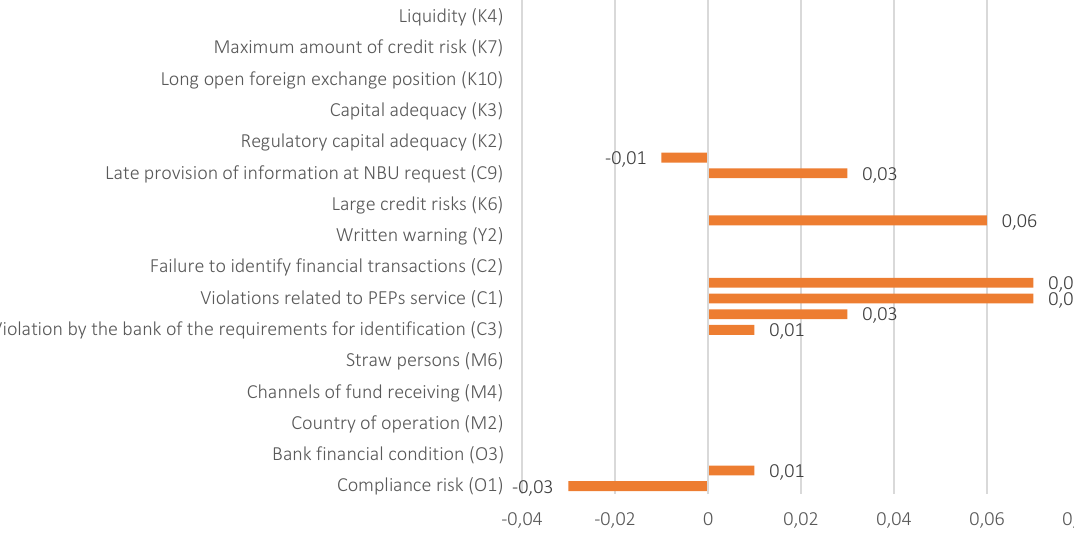
Figure 3. Forecasted variability of compliance indicators and the bank’s counterparties’ expectations in the non-state pension sphere affected by the changes in